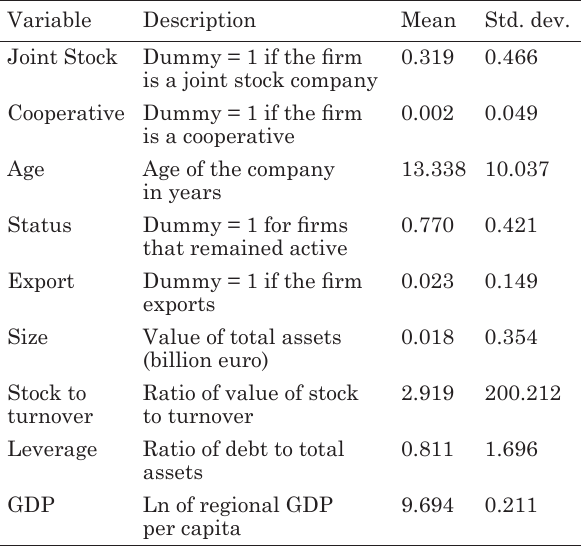
Table 2. Descriptive statistics of the variables used in the bootstrap truncated regression (monetary values